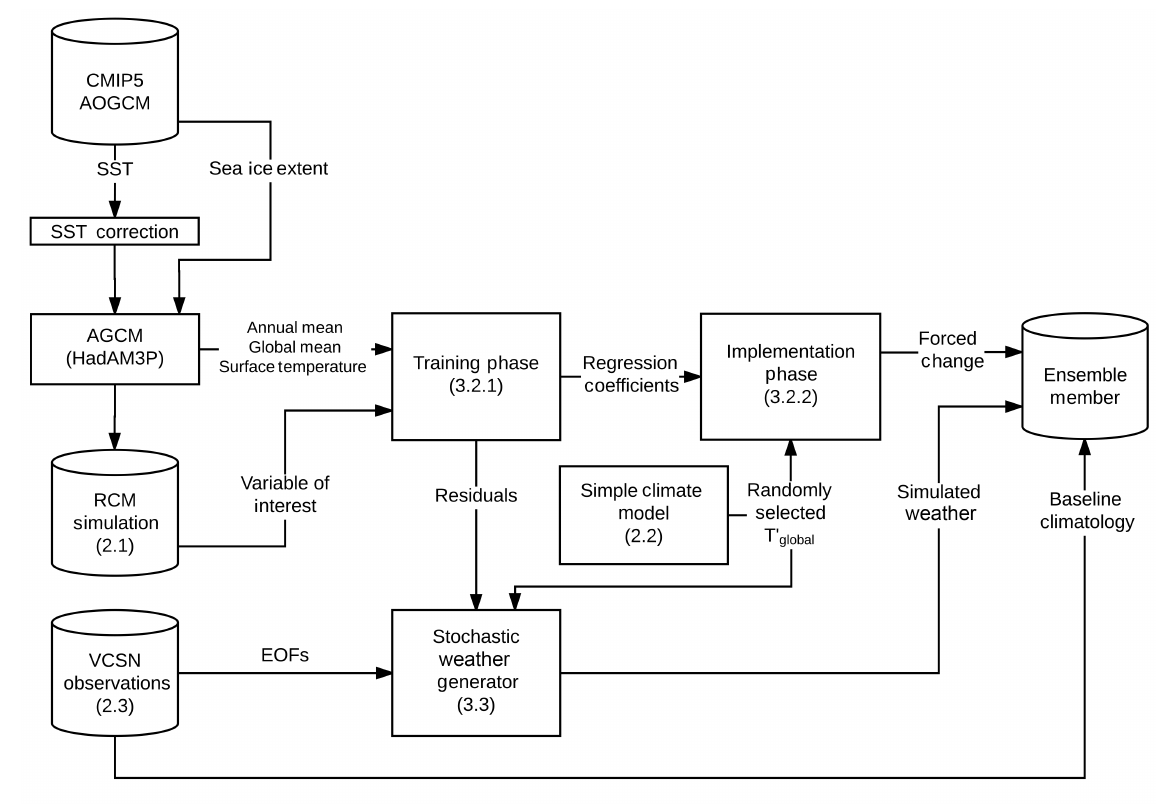
Figure 1. Flow chart illustrating the processes involved in generating a single EPIC ensemble member based on training from a selected RCM simulation. Numbers in brackets refer to the section in the text where more details are